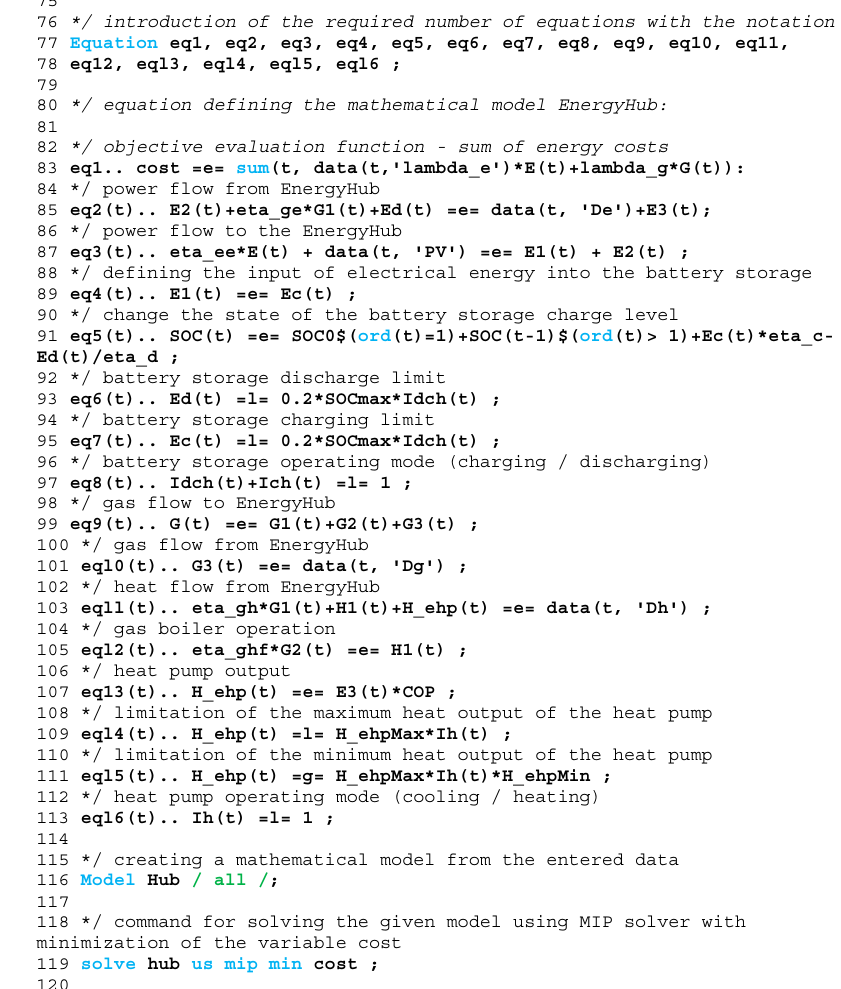
Figure 25. Formulation of mathematical model equations in GAMS code. Evaluation of results: